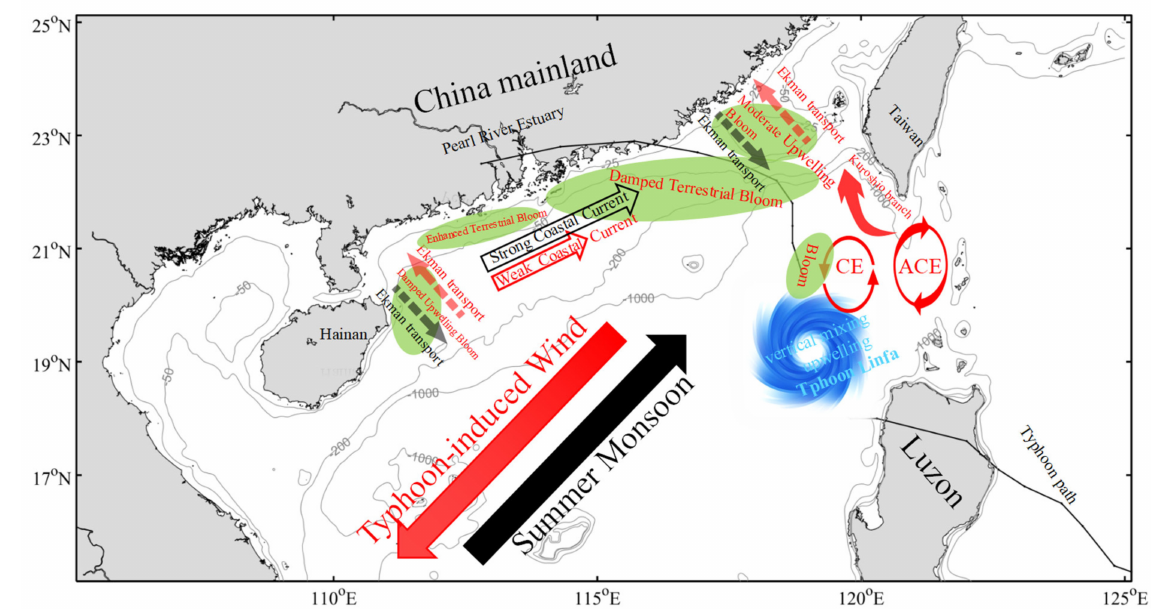
Figure 17. Schematic diagram illustrating phytoplankton dynamics in the northern SCS during the passage of typhoon